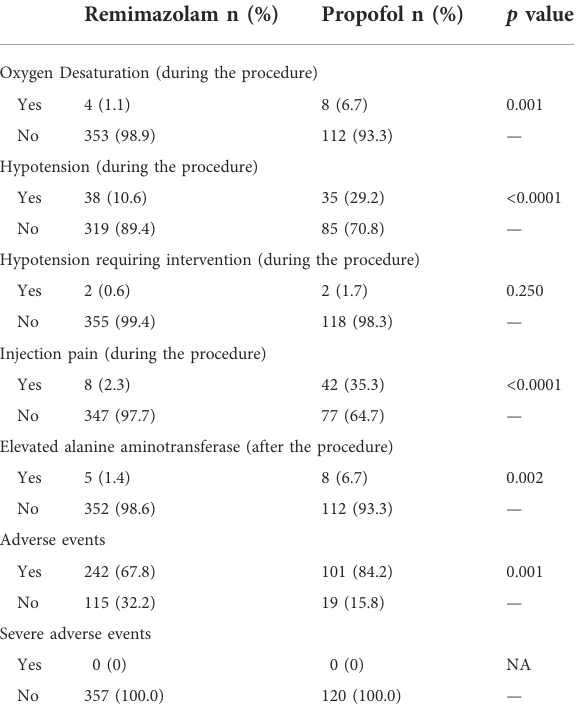
TABLE 5 Incidence of major adverse events. TABLE 6 Time (min) from the start of administration of study drug to MOAA/S score ≤ 3 in successfully sedated